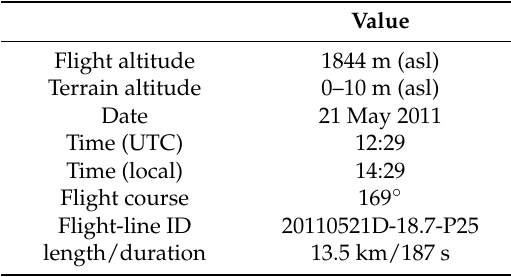
Table 1. Summary of acquisition parameters of airborne campaign.